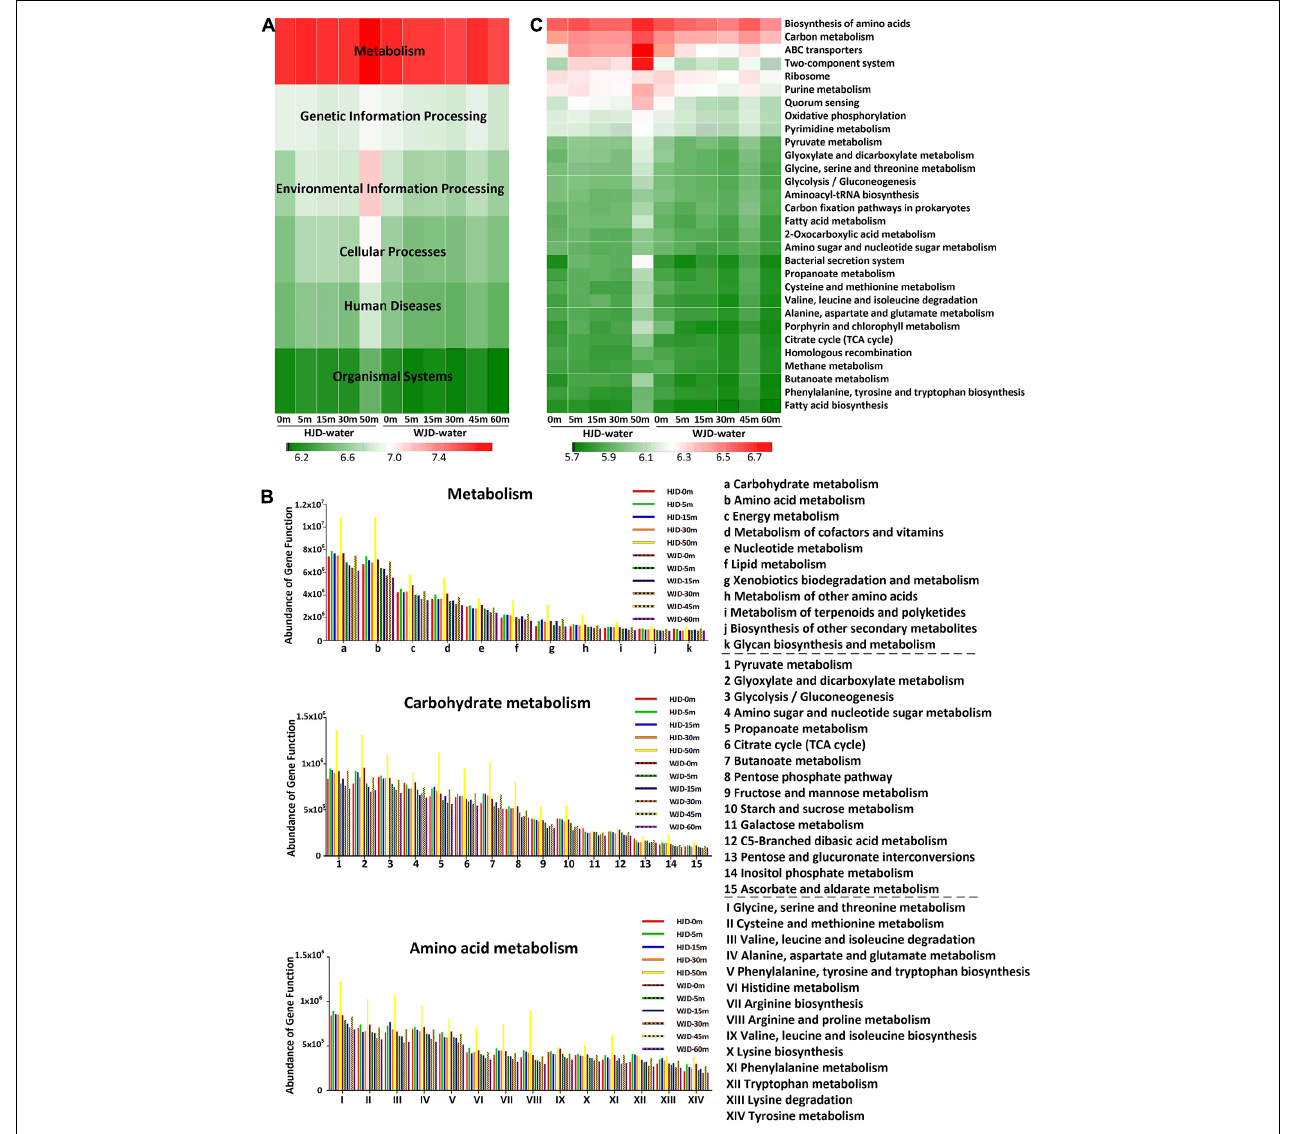
FIGURE 4 | Functional prediction of the bacterial communities at different depths in two reservoirs. (A) Relative abundances of metabolic pathways on KEGG categories (level 1). (B) Relative abundances of metabolism (level 2), carbohydrate metabolism and amino acid metabolism (level 3) based on KEGG categories. (C) Relative abundances of top 30 metabolic pathways based on KEGG categories (level